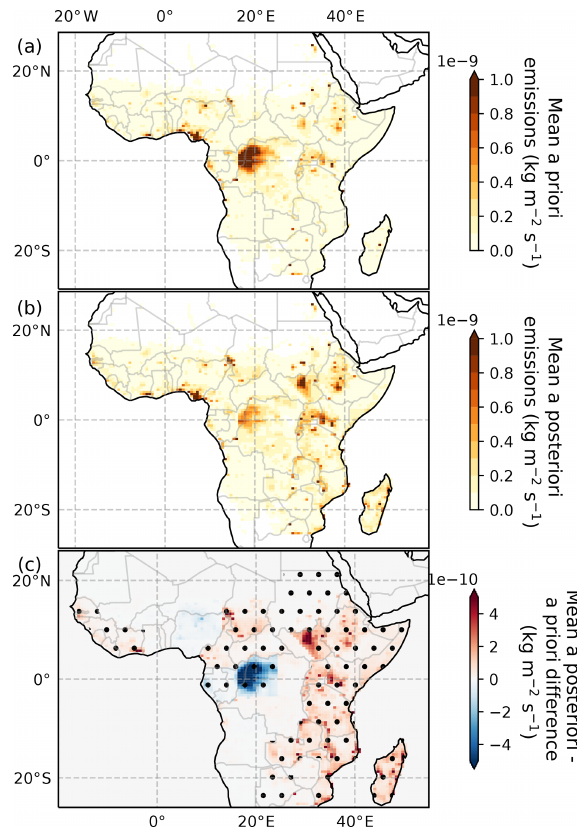
Figure 3. The 2010–2016 mean (a) a priori and (b) a posteriori spatial distribution of CH 4 emissions in the tropical African domain from the PR1 inversion. (c) Mean PR1 a posteriori minus a priori differences, 2010–2016. Stippling indicates areas where the a priori mean was outside the a posteriori 95% uncertainty range for both PR1 and PR2